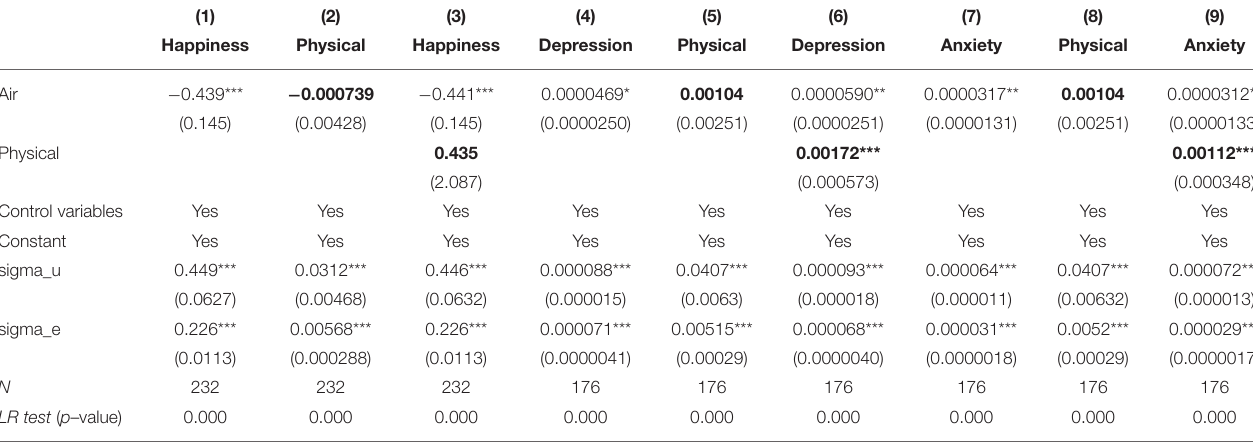
TABLE 12 | Test of mediating effect of physical health on the effect of air pollution on mental health.